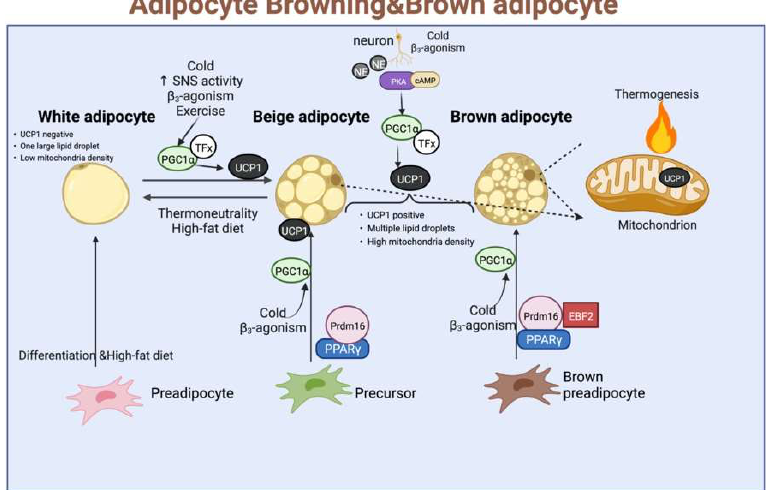
Figure 3. The classic regulatory model for the development of brown fat, beige fat, and white fat, as well as thermogenesis, involves stimulation by external conditions such as cold stimuli, catecholamines, norepinephrine, and exercise. TFx: Trans factors X, where UCP-1 is activated and enters the inner mitochondrial membrane to expend energy in the form of heat dissipation.